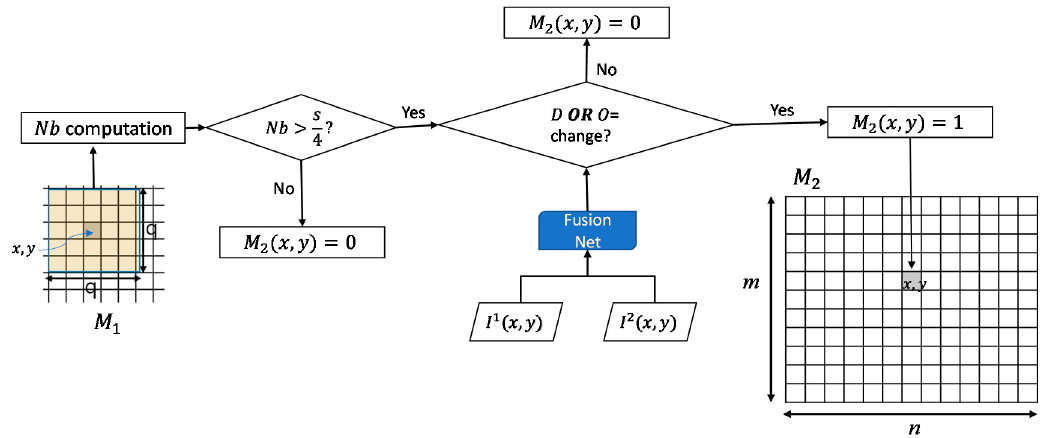
Figure 5. Second prediction flowchart.